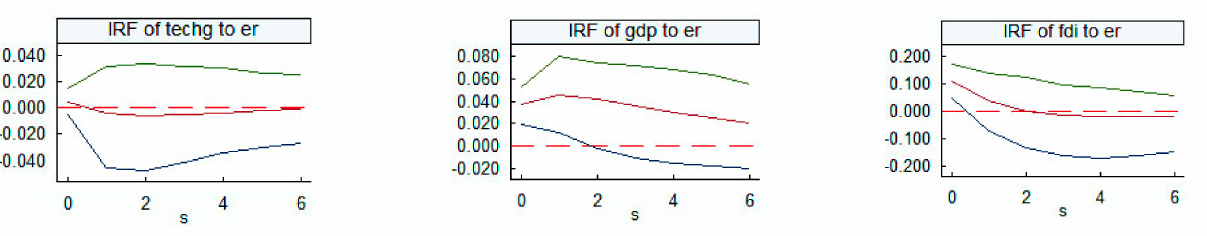
Figure 3. Impulse response graphs for the relationship of each variable to environmental regulation. Note: On the left is an impulse response plot of the techg on er, the middle one is an impulse response plot of the gdp to er, and the right one is an impulse response plot of the fdi to er. IRF—impulse response